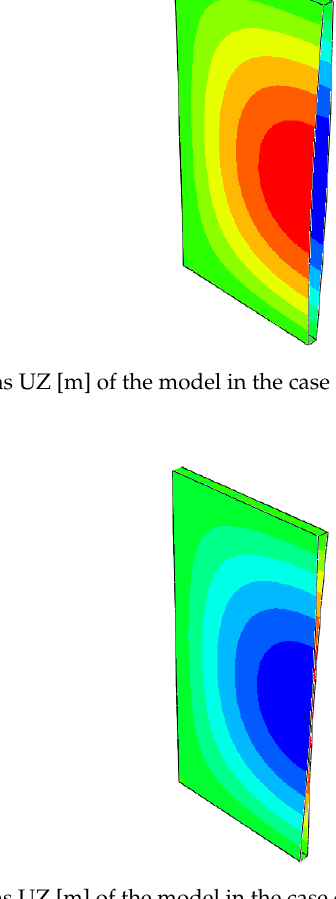
Figure 6. Deformations UZ [m] of the model in the case of withdrawal of 100 mL of air (test series 6) from the gap.